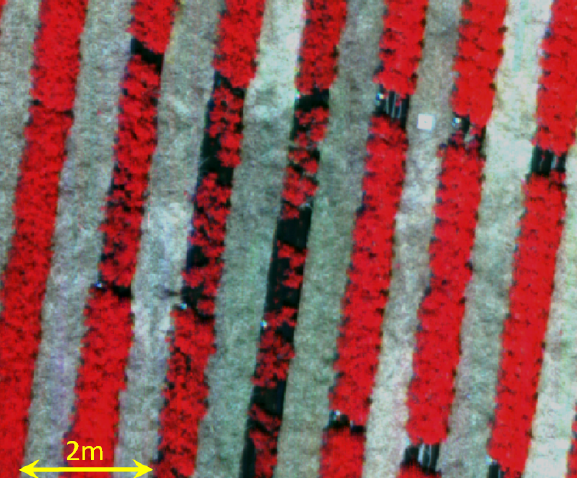
Figure 5. Strawberry field near Sint Truiden, Belgium, imaged with